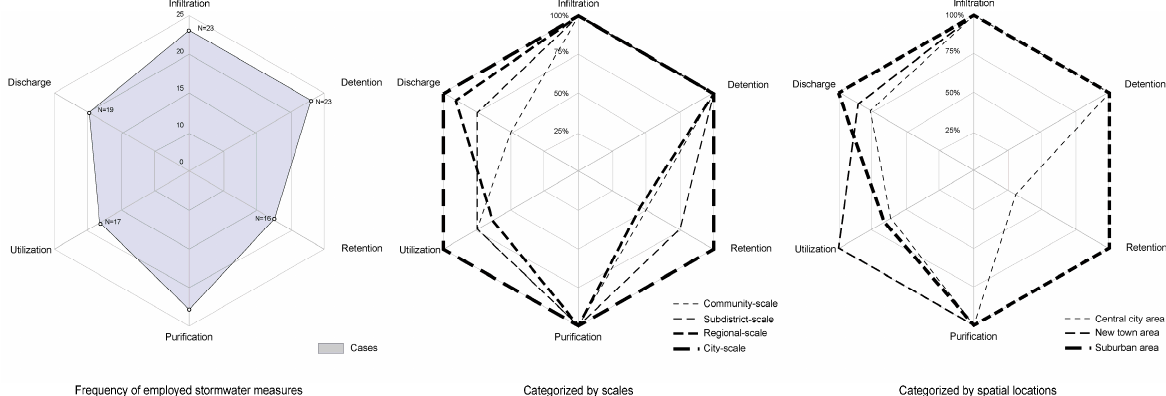
Figure 3. The implementation of stormwater